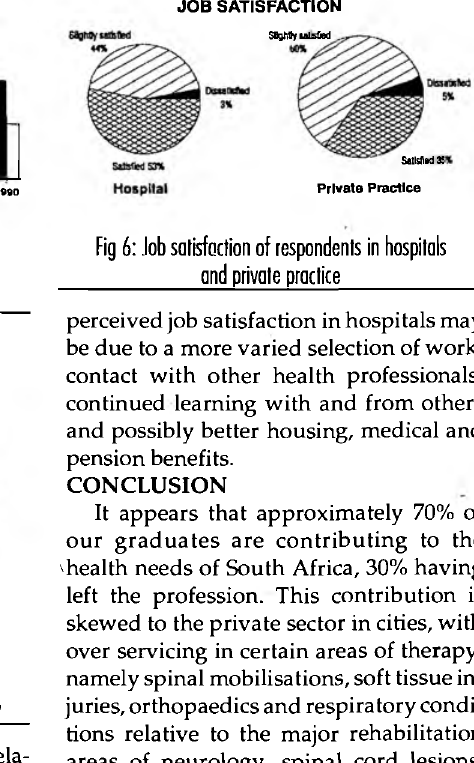
Fig 6: Job satisfaction of respondents in